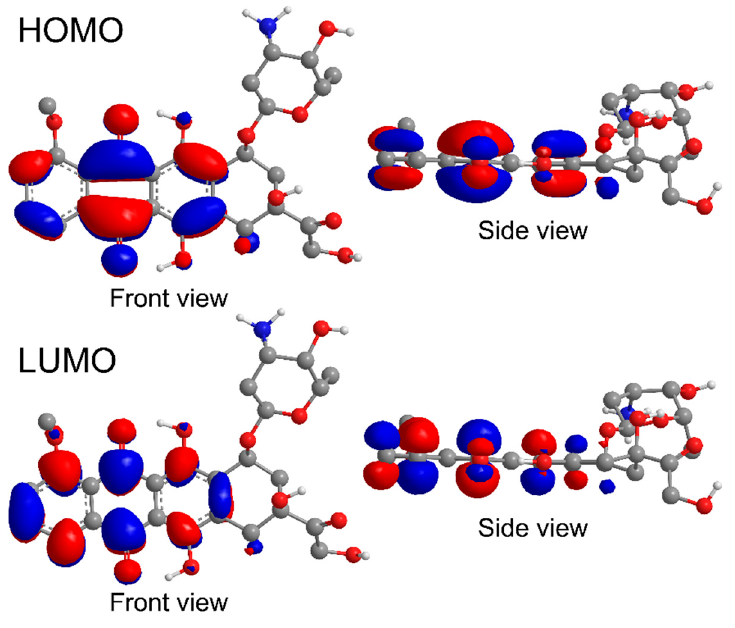
Figure 9. Electrostatic potential surface of HOMO and LUMO of DOX in the front and side view.